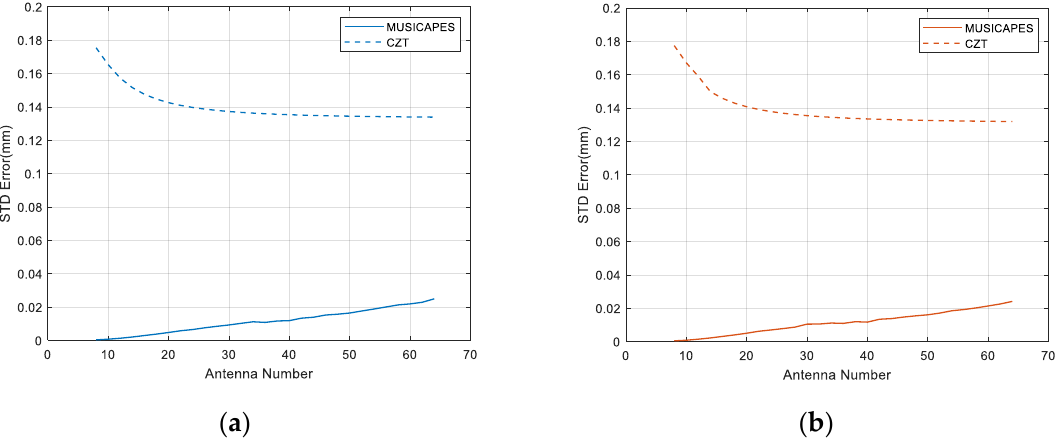
Figure 10. STD of displacement difference vs. array length. ( a ) STD of ‘Target 1 ’ ; ( b ) STD of ‘Target 2 ’ .